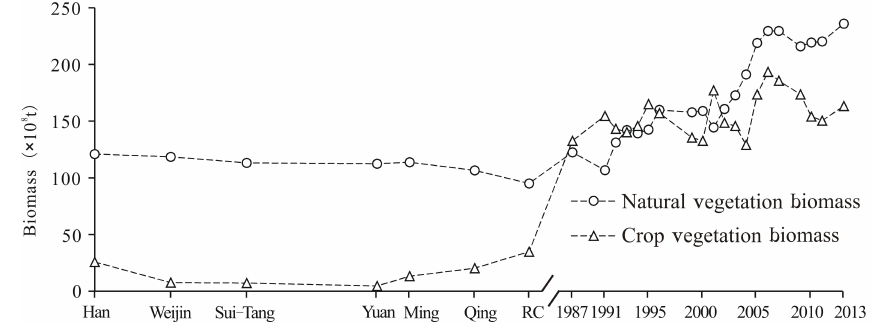
Figure 6. Temporal variations in the biomass of natural vegetation (triangle) and crops (circle) over the past 2000 years.